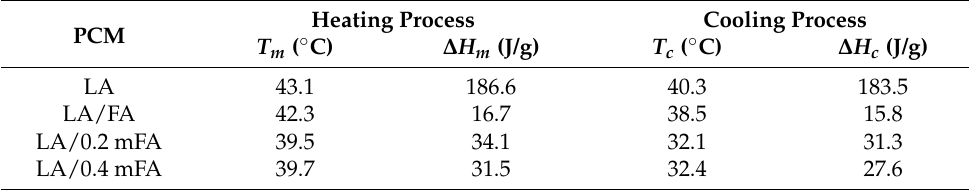
Figure 7. Differential scanning calorimetry (DSC) curves of LA, LA/FA, LA/0.2 mFA, and LA/0.4 mFA. Table 2. Phase transition temperature and corresponding